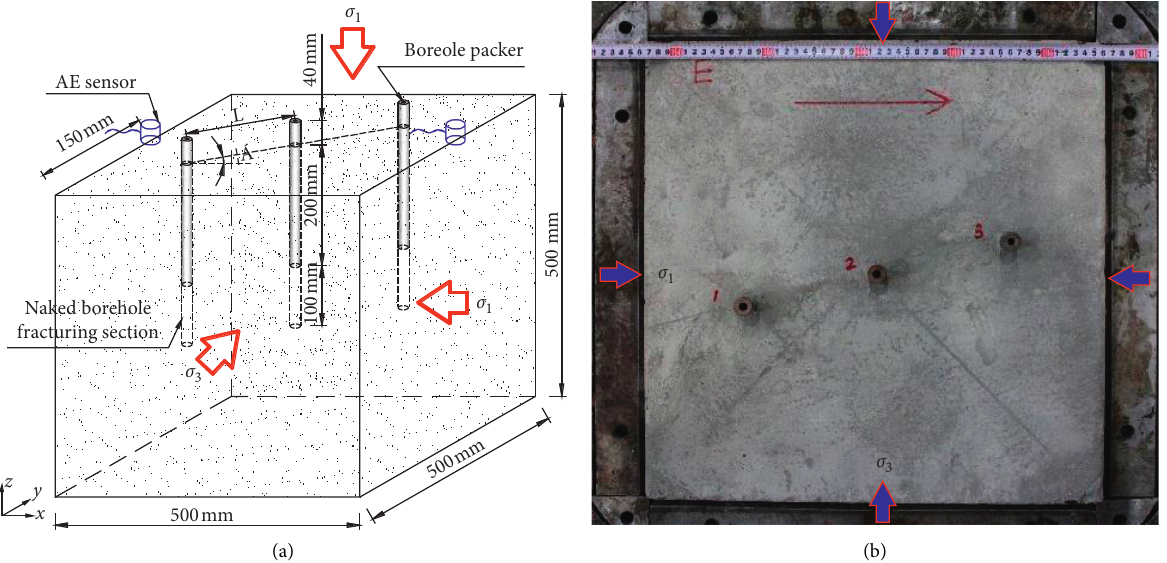
Figure 3: The cement mortar test block. (a) Size structure and loading schematic diagram [23]. (b) Test block placed in the pressurized frame.